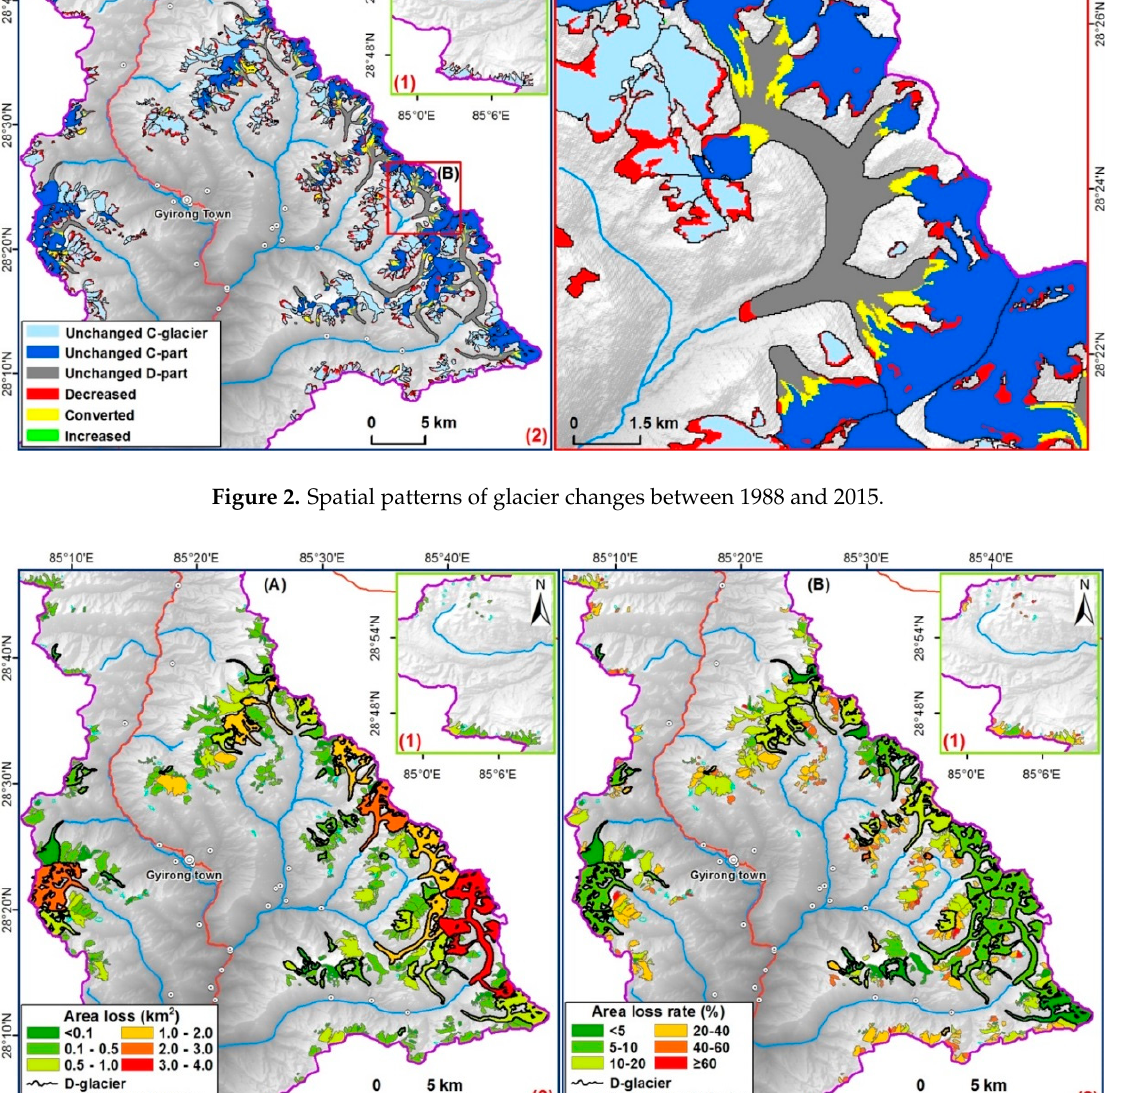
Figure 4. Area and frequency of glaciers in various size classes: ( A ) glacier total areas in the studied six years; ( B ) C-glaciers in 1988 and 2015; ( C ) D-glaciers in 1988 and 2015. Glacier numbers are given in green. 3.2. Hypsometry and Topographic Characteristics of Glaciers Glaciers and glacier changes show distinct altitudinal distributions between 1988 and 2015 (Figure 5). In 2015, the altitudes of all glaciers in GRB range from 3600 m a.s.l. to 7300 m a.s.l., with a mean altitude of 5507 m a.s.l. The majority glacier area is distributed at 5000–6000 m a.s.l., occupying 71.22% of the total glacier area (Figure 5A). C-glaciers generally have a higher altitude than that of D-glaciers (Figure 5B), within which C-parts are distributed higher than D-parts (Figure 5C). In total, glacial area loss between 1988 and 2015 mainly occurred at 4800–6000 m a.s.l. (Figure 5A). Specifically, most area losses of C-glaciers are observed at 4800–5900 m a.s.l. and for D-glaciers at 5200–5800 m a.s.l. (Figure 5B). In contrast, the increasing areas of D-part are more prominent in higher elevations (mainly from 4900 m a.s.l. to 5500 m a.s.l.) on D-glaciers that previously be covered